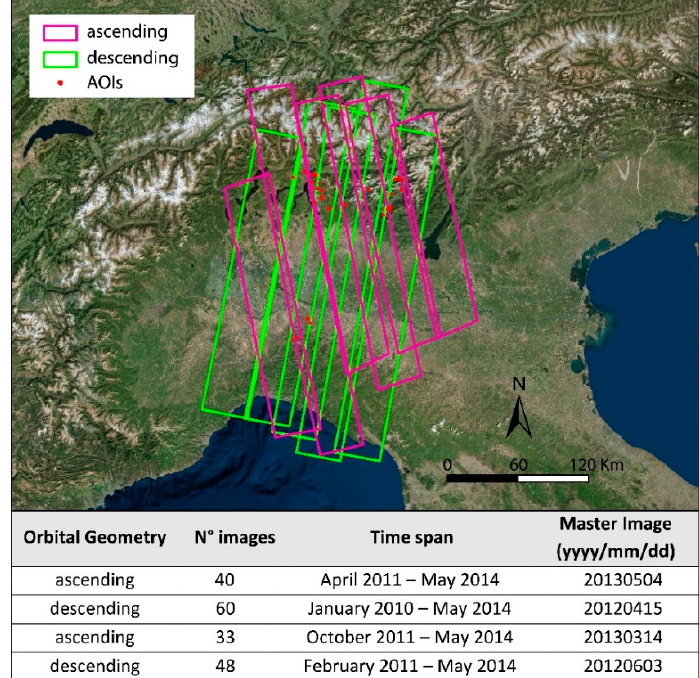
Figure 7. Footprints and characteristics of the COSMO-SkyMed images.